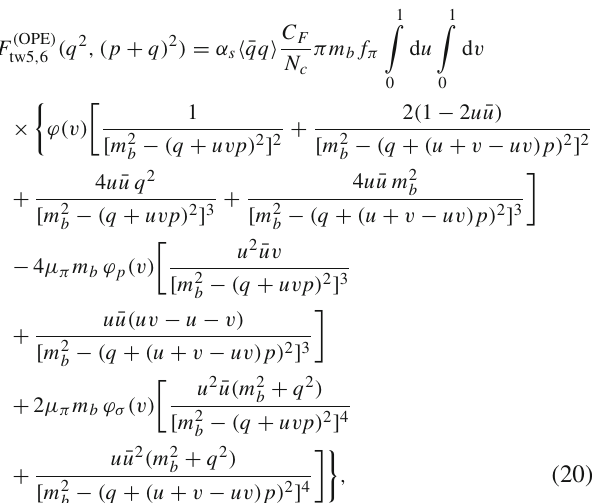
They are formed only by the gluon emitted from the vir- tual b -quark. Gluons emitted from the light and converted to the quark–antiquark pair represent a gen- uine long-distance effect which is by default included in the DAs. Such an implicit separation of long- and short-distance effects takes place also in the diagrams with three-particle quark–antiquark–gluon DAs of twist 3,